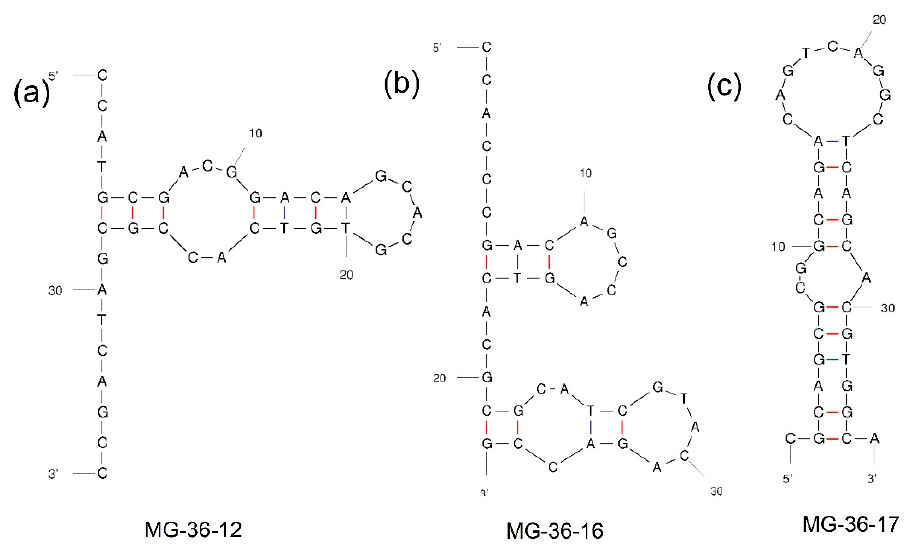
Figure 3. The secondary structures of the MG-36-12 ( a ), MG-36-16 ( b ), and MG-36-17 ( c ) candidate aptamer were predicted by Mfold. Table 2. Sequence (5 ′ -3 ′ ) predicted folding energy ( Δ G) and dissociation constants (K d ) values of aptamer candidates.